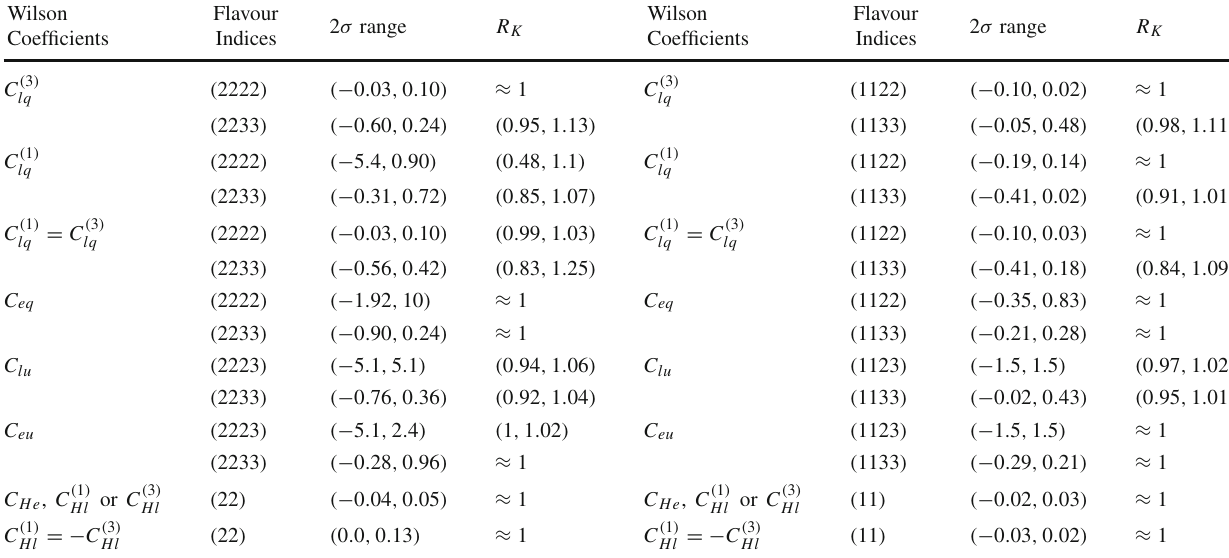
Table 2 Allowed range of values of the WCs and of R K ≡ R [ 1 , 6 ] for each of the operators listed in Sect. 3.1, after imposing all the con- straintslistedinSect.3.2exceptfortheLHCcontactinteractionbounds. The range of R K ∗ in the central q 2 bin is virtually identical to the R K range. We fix (cid:3) = 1 TeV and enforce | C | ≤ 10, which corresponds